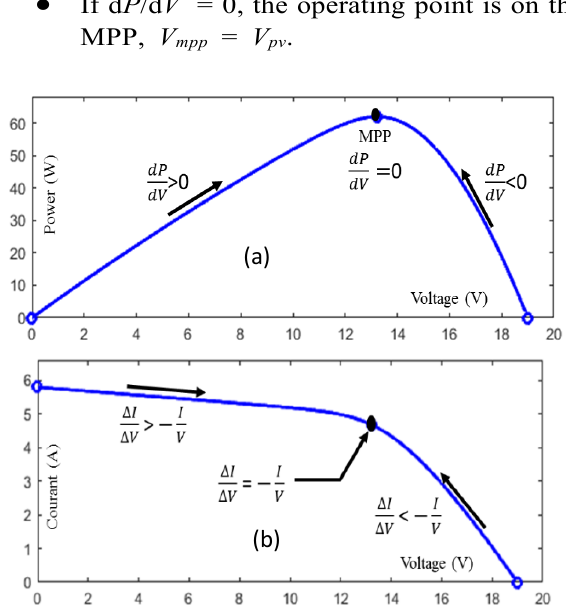
Figure 5: Positioning of the (a) operating point according to the sign of the derivative of the conductivity Gc and (b) the power P